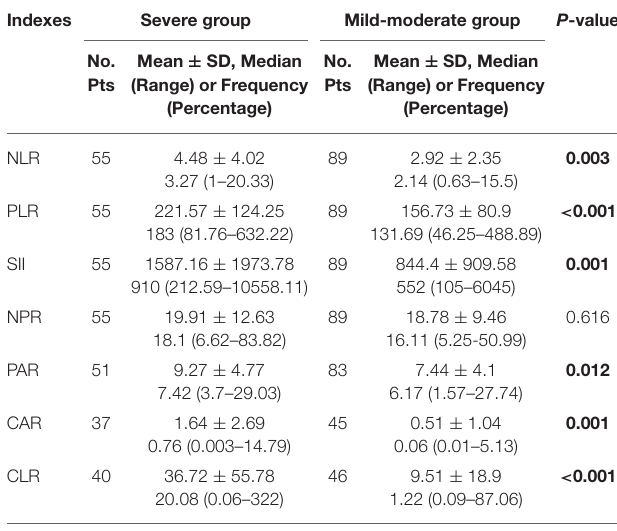
TABLE 4 | Comparison of inflammatory indexes between severe and mild-moderate UC groups.